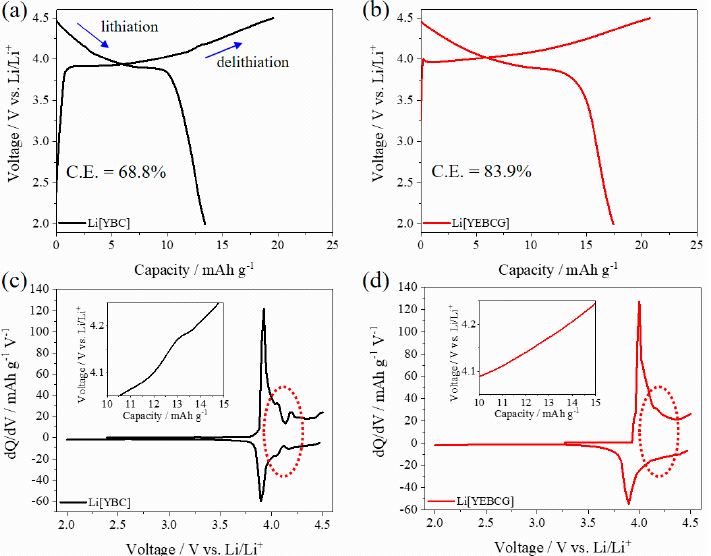
Figure 4. ( a , b ) Initial charge/discharge and ( c , d ) differential capacity curves of Li[YBC] and Li[YEBCG], respectively. A distinct phase transition region (red-dotted circles in ( c , d )) in the potential around 4.2 V was displayed with insets of the corresponding voltage profile. (C.E.: Coulombic